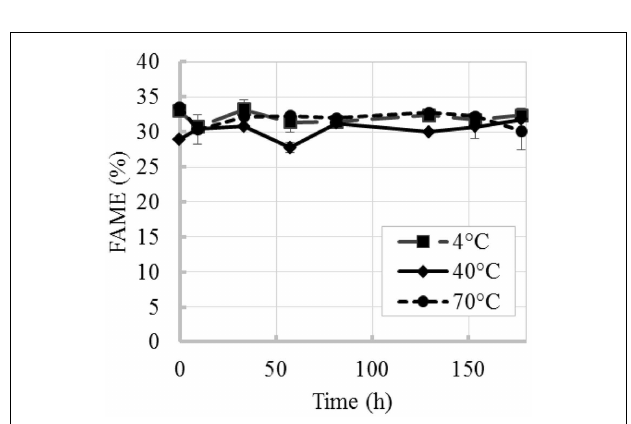
FIGURE 2 |Time evolution of FAME content at three different temperatures . (A) Percent FAME per unit of biomass (% total DW), (B) Total FAME per vial. Initial biomass was 2g/L. Error bars represent SD from three independent experiments. SD not visible is overlapped with the symbols.